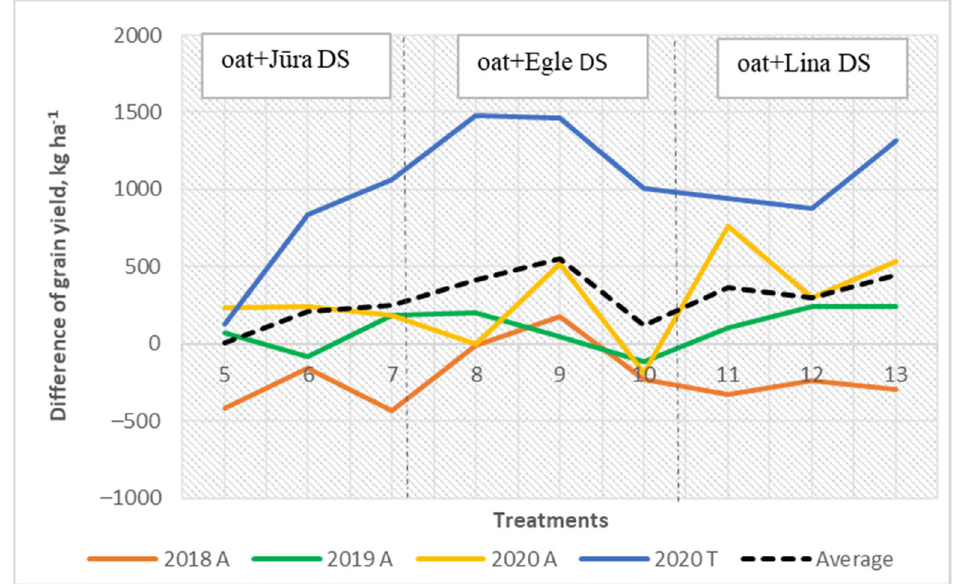
Figure 4. The combined total grain yield: difference between actual and expected grain yield. However, the grain yield of pea in the mixed cropping systems showed was higher with the new cultivar Lina DS (Figure 5). However, oat grain yield decreased when field pea yield was higher in the mixed cropping systems (Figure 6).